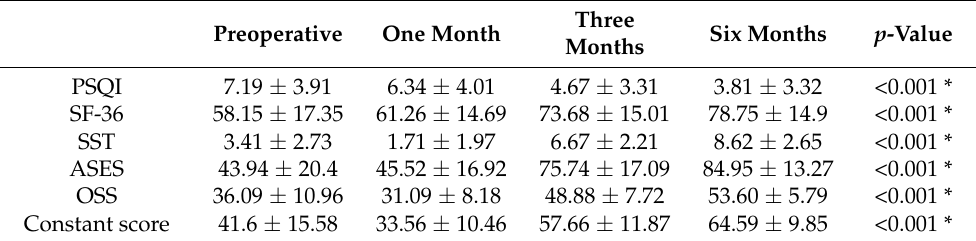
Table 1. Statistical follow-up analysis (mean ± SD). Note: * = statistically significant.